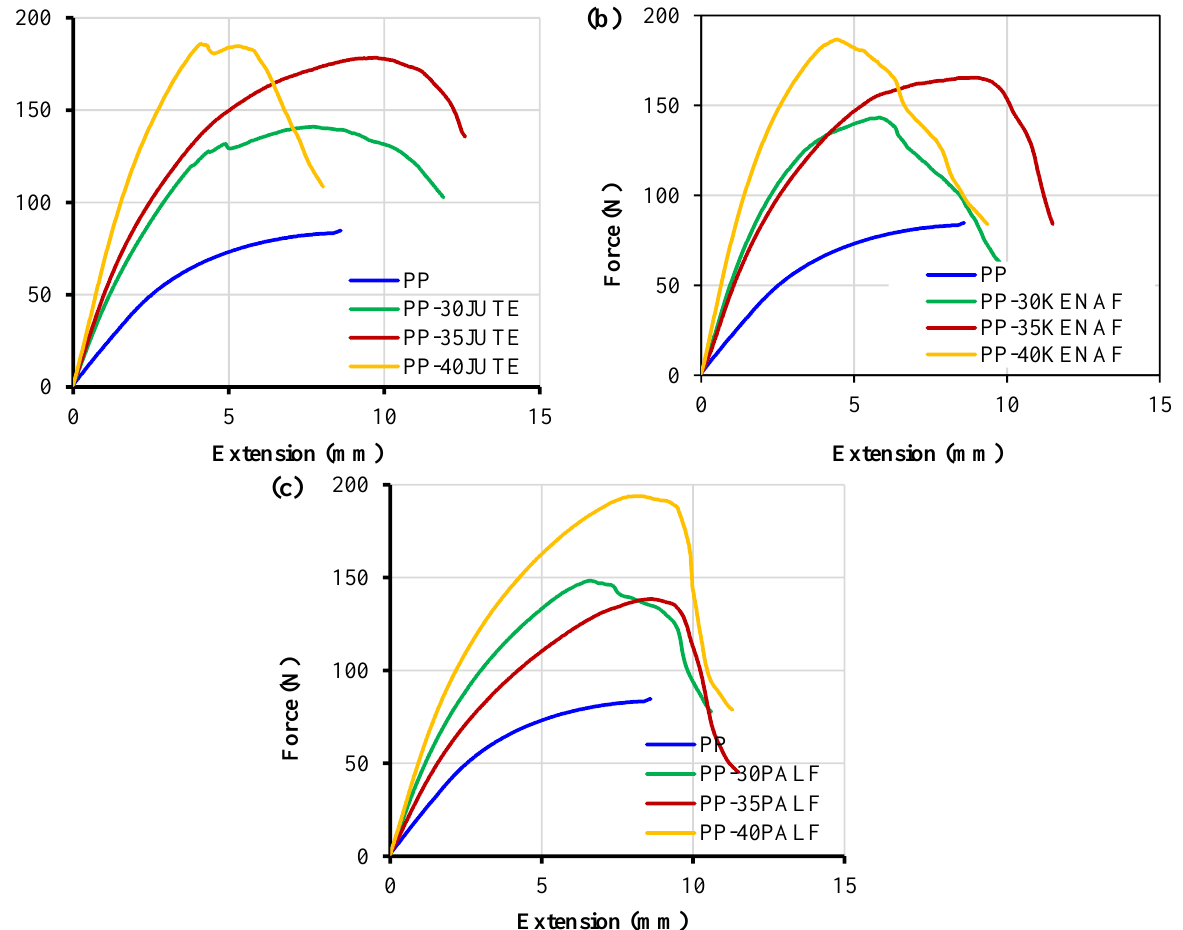
Figure 9. Force vs. extension graphs during flexural testing of the composite specimens ( a ) jute, ( b ) kenaf, and ( c ) PALF.